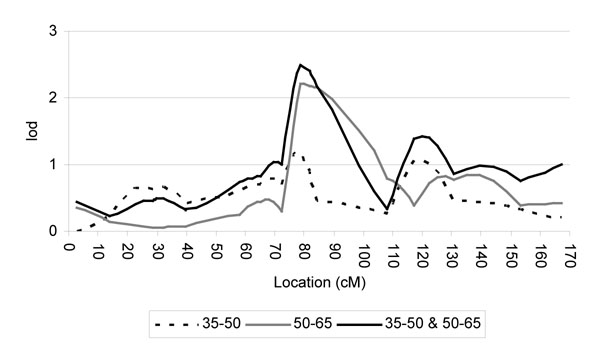
QTL LOD scores for SBP residuals, chromosome 17.